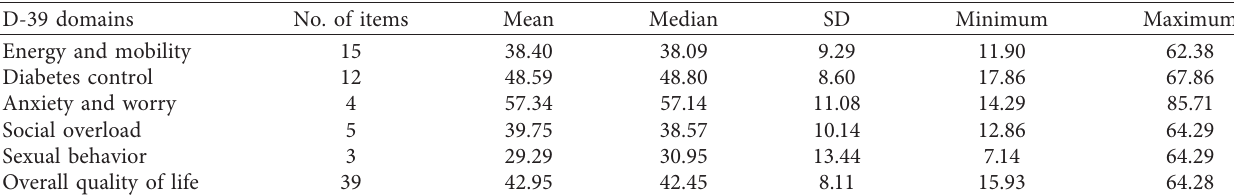
Table 2: Descriptive study of the D-39 questionnaire.